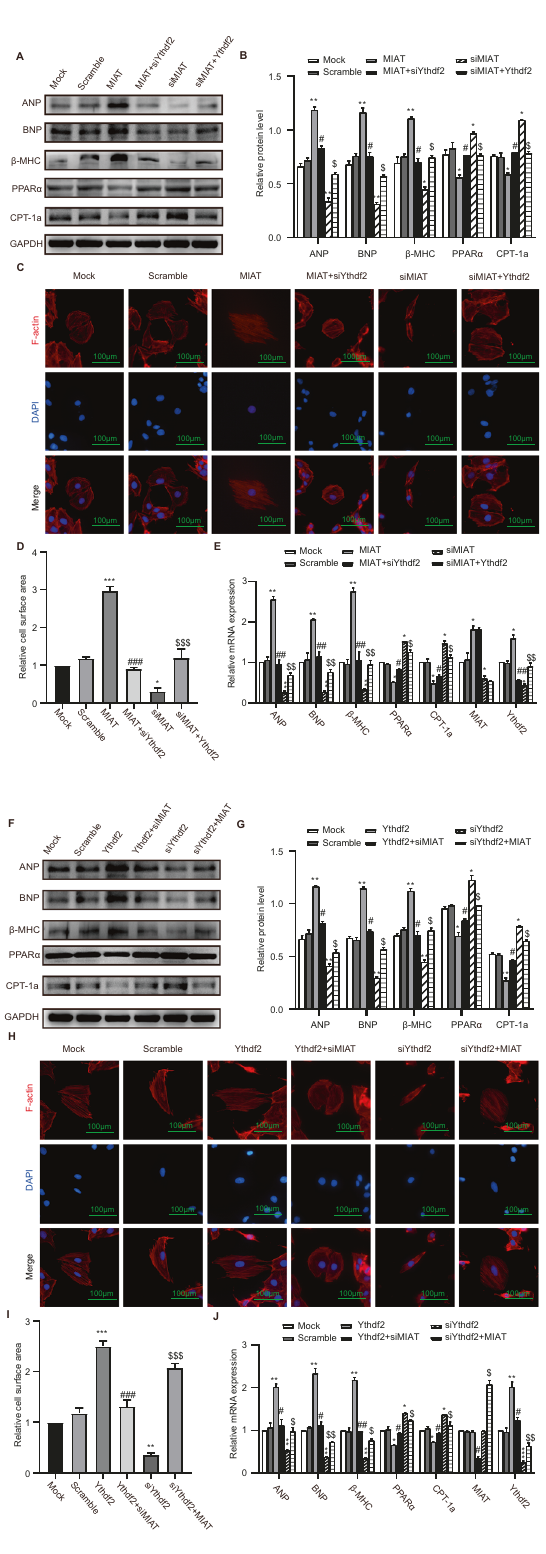
In our previous study, we demonstrated that downregulation of MIAT could inhibit the expression of cardiac hypertrophy indicators ANP and BNP in ISO-treated neonatal rat ventricular myocytes (NRVMs) [32]. Other studies reported similar results in diabetic myocardial changes [33], suggesting that MIAT was